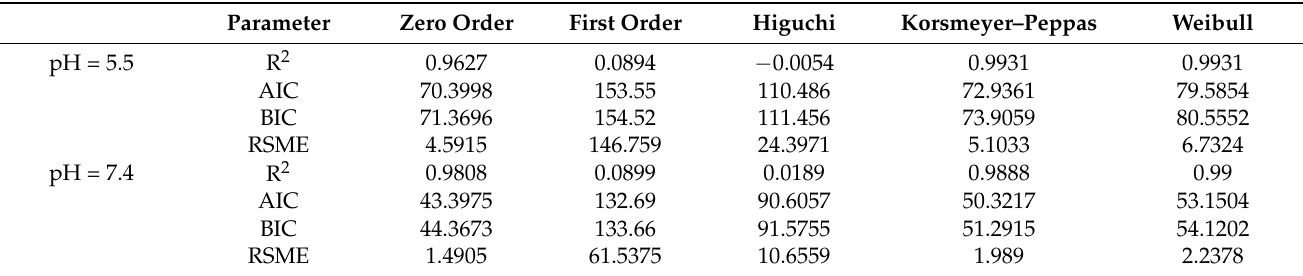
Table 2. The estimated parameters, R 2 , AIC, BIC and RSME values obtained from fitting experimental release data at pH 5.5 and pH